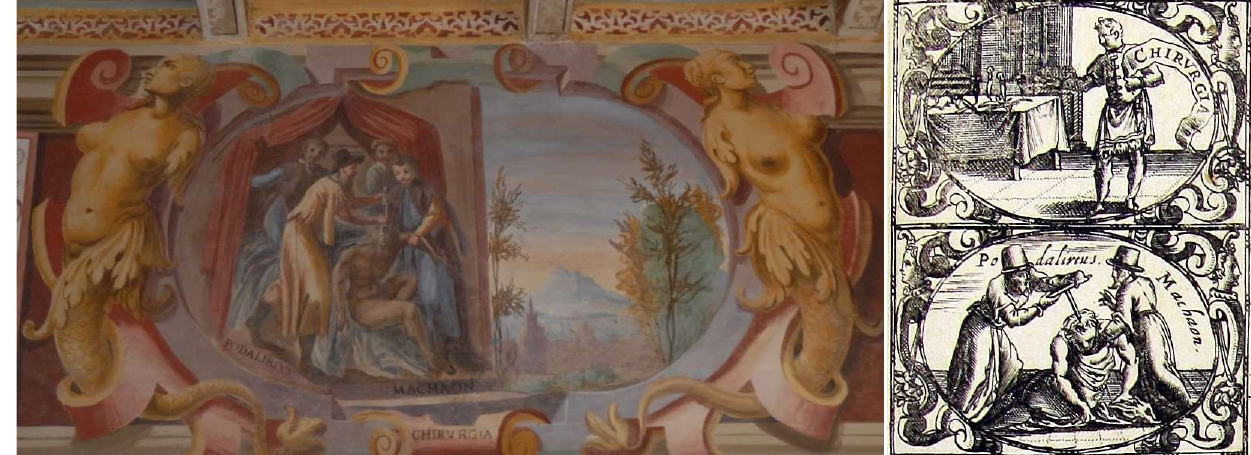
Figure 5. Left : Oval painting dedicated to surgery, where Podalirius and Machaon are depicted. Right : A similar detail taken from the frontispiece of Giunti’s edition.